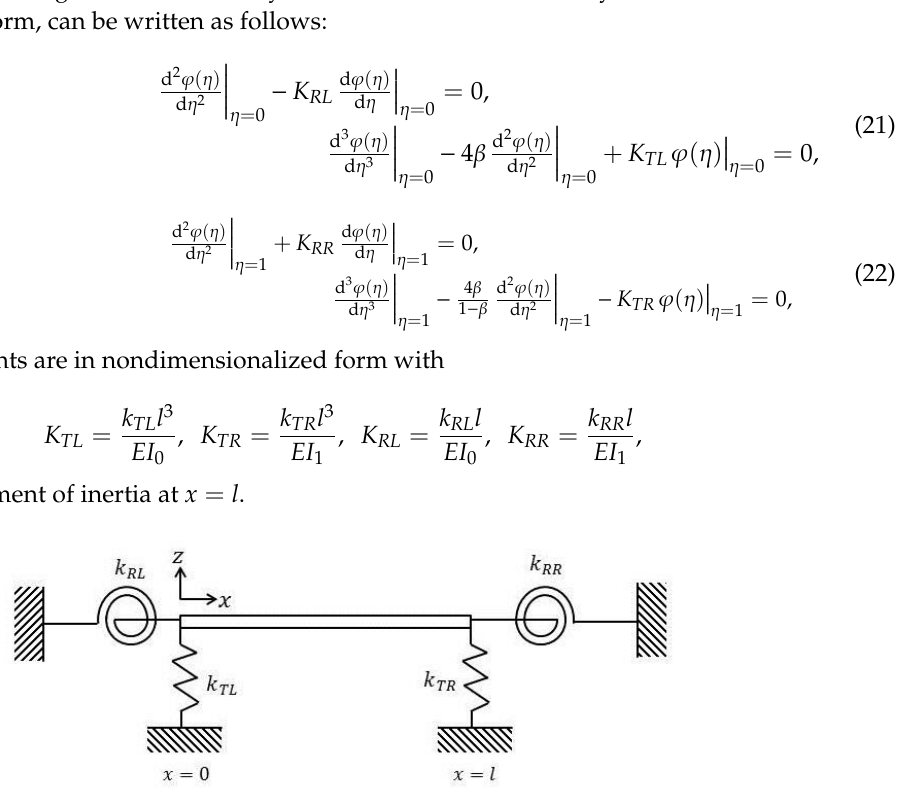
Figure 2. Boundary conditions using translational and rotational spring coefficients.